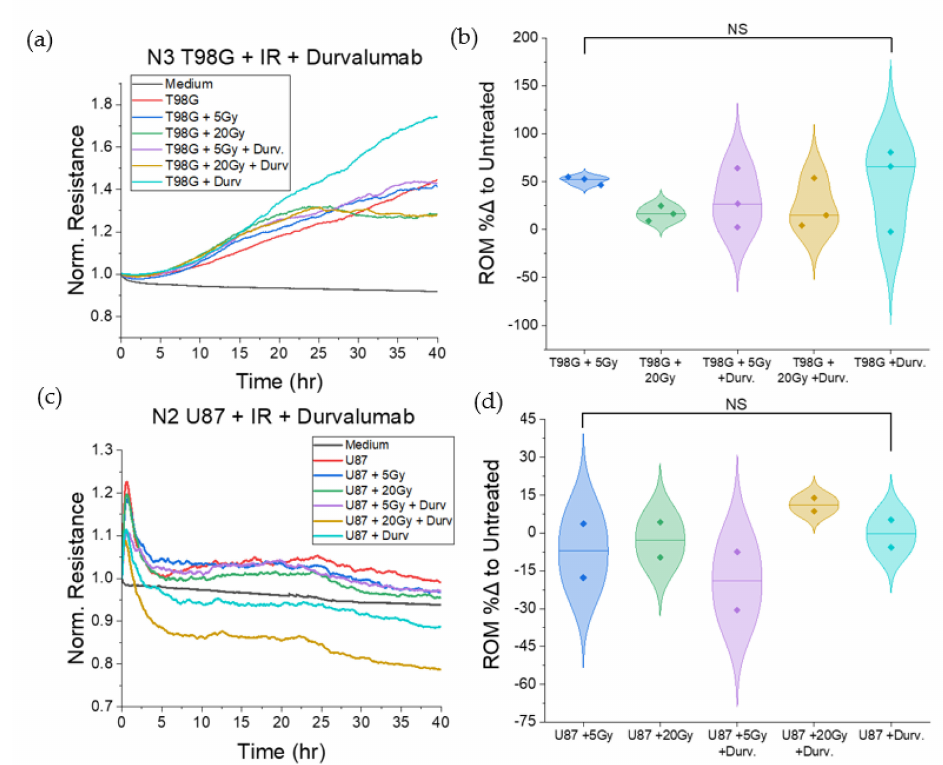
Figure 3. Migration-focused results of ECIS tests on T98G and U87 glioblastoma cells treated with radiation and durvalumab. ( a ) Representative plot of normalized resistance in the first 40 h post- treatment for T98G. ( b ) Violin plot of percent differences in ROM for ( a ), relative to the untreated T98G control. ( c ) Representative plot of normalized resistance in the first 40 h post-treatment for U87. ( d ) Violin plot of percent differences in ROM for ( c ), relative to the untreated U87 control. NS